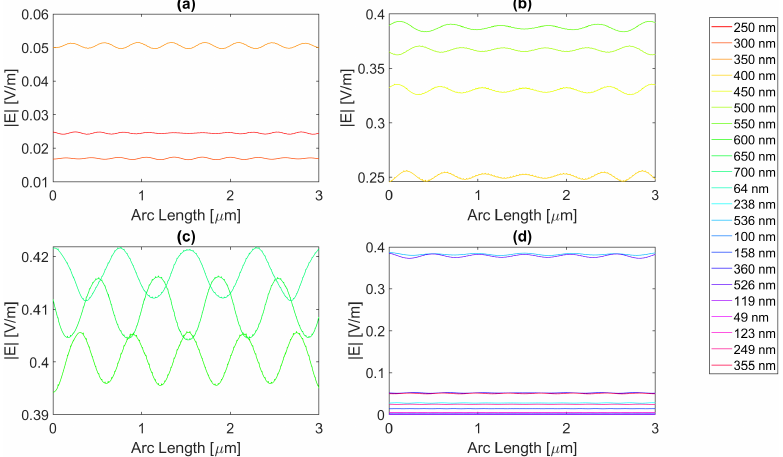
Figure 3. Electric field at probe 1 for the stand-alone Si